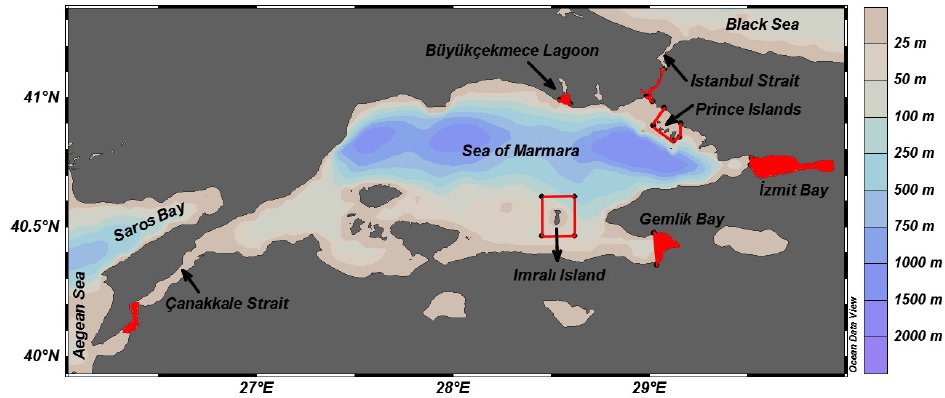
Figure 1. Permanently closed areas (in red) for purse seine fishing in Marmara Sea [7].